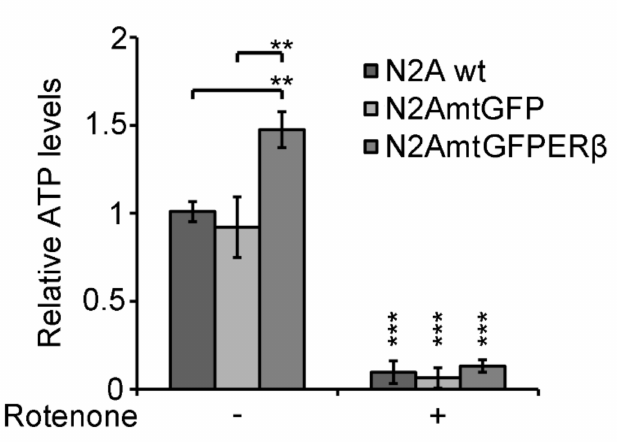
Figure 6. Effect of the mitochondrial ER β on ATP levels in N2A, N2AmtGFP, and N2AmtGFPER β cells. Equal numbers of N2A, N2AmtGFP, and N2AmtGFPER β cells were plated on six well plate. At 70–80% confluency, cells were incubated with 0.2 µ M rotenone (diluted in DMSO) for 16 h. Control cells were treated with equal volumes of DMSO. Subsequently, cells were washed in PBS, harvested, and subjected to ATP measurements, applying ENLITEN ATP bioluminescence assay as described in experimental section. Results are expressed as relative luciferase units, normalized against relative protein levels and represent the mean ± SD of three independent experiments. ** p < 0.01, *** p < 0.001. ATP levels at vehicle-treated N2A cells were set at 1. Vertical asterisks represent statistically significant differences compared to the respective vehicle-treated cells of each cell line, while horizontal lines and the respective asterisks correspond to statistically significant differences between cells from different cell